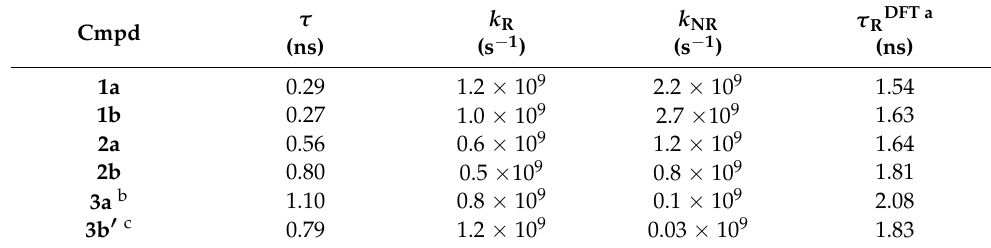
Table 1. Photophysical properties of quadrupoles 1a , b and 2a , b vs. those of 3a and 3b ′ in toluene (unless otherwise stated). Table 2. Fluorescence lifetime ( τ ), radiative ( k R ) and non-radiative ( k NR ) decay constants, and the theoretical fluorescence lifetime in the absence of other deactivation processes ( τ FDFT ) for 1a , b , 2a , b and 3a , b’ in toluene (unless otherwise